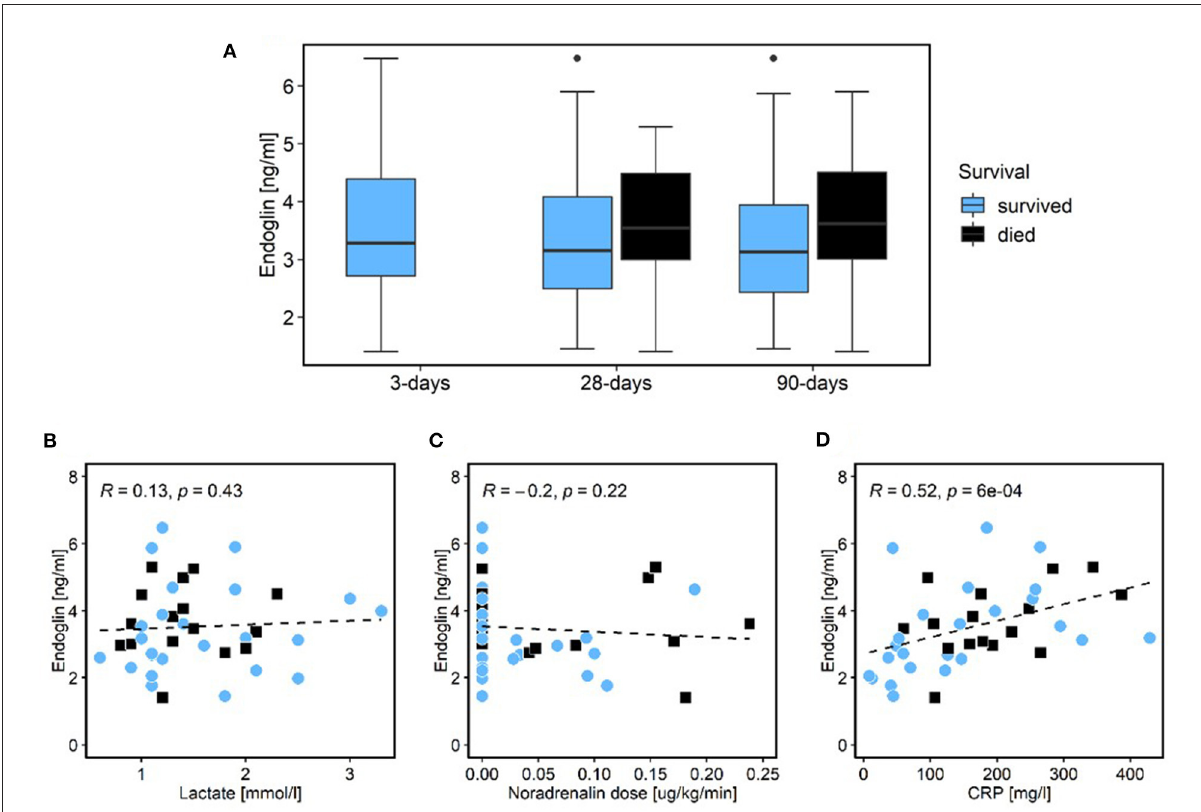
FIGURE2 COVID-19 cohort. Relationship of patient survival and level of sEng. None of the patients died within the first 3 days of admission [blue color survivors; black color non-survivors; (A) ]. Correlations of sEng and lactate (B) , noradrenalin dose (C) , and CRP [ (D) ; blue dots survivors; black squares non-survivors]. sEng, soluble endoglin; SOFA, sequential organ failure assessment; CRP, c-reactive